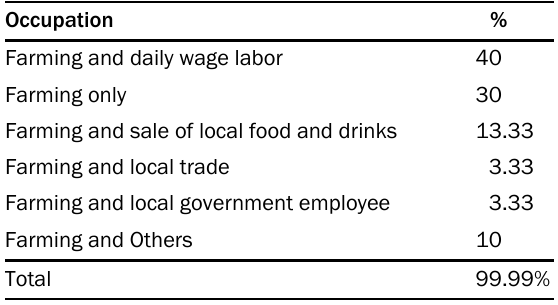
Table 1. Household Economic Activity in Guto Gidda